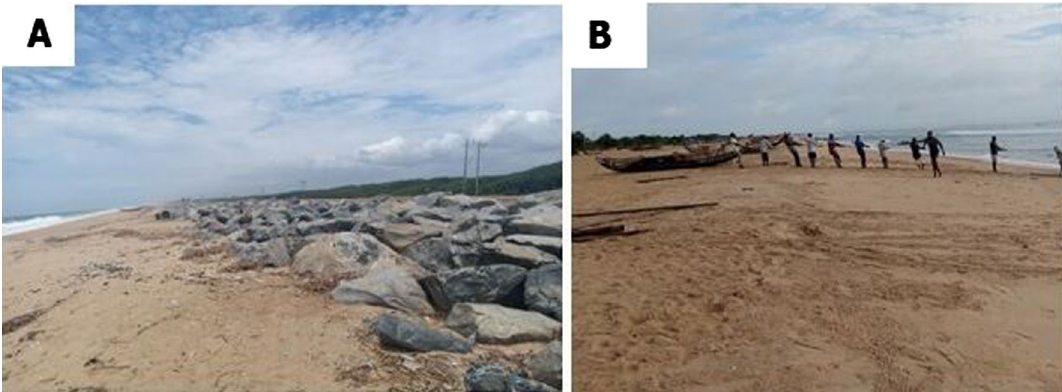
Fig. 2 A : Revetments of the Keta sea defence project at Atorkor-Anyanui stretch. B: Fishermen pulling a net on the nourished beach without impediments from